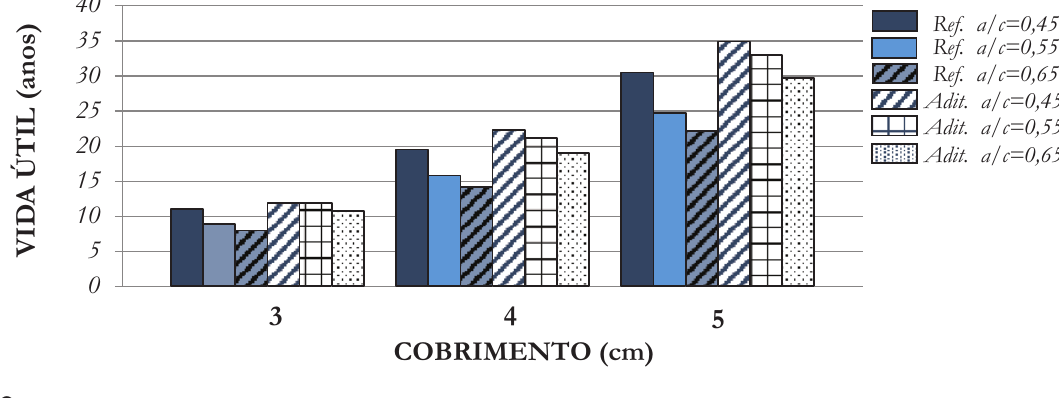
Estimativa de vida útil – baseada nos concretos com período de cura de 28